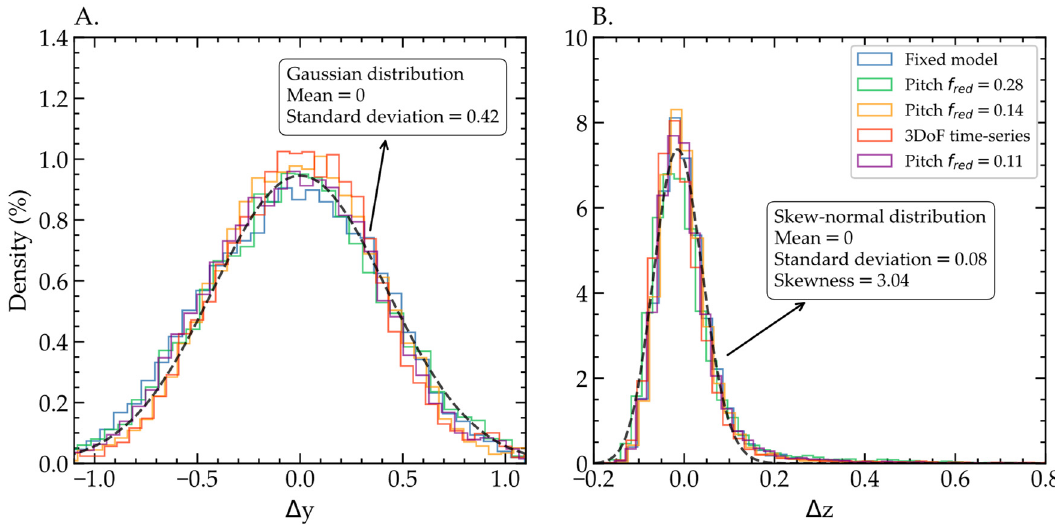
Figure 8. Probability density function (PDF) of wake centres lateral (( A ) ∆ y) and vertical (( B ) ∆ z) locations at x = 8.125 D.